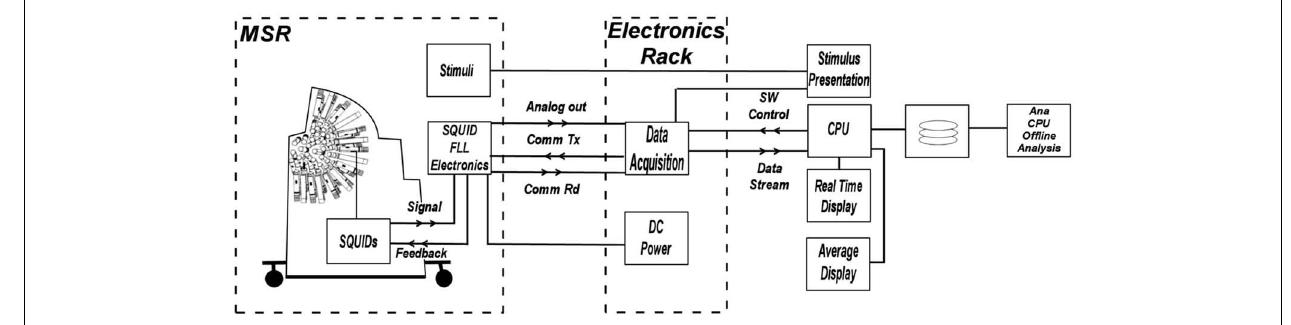
FIGURE 2 | Block diagram of electronics system functions. The architecture provides control and real-time processing for MEG, EEG, and A/D input channels as well as fast off-line processing. The acquisition